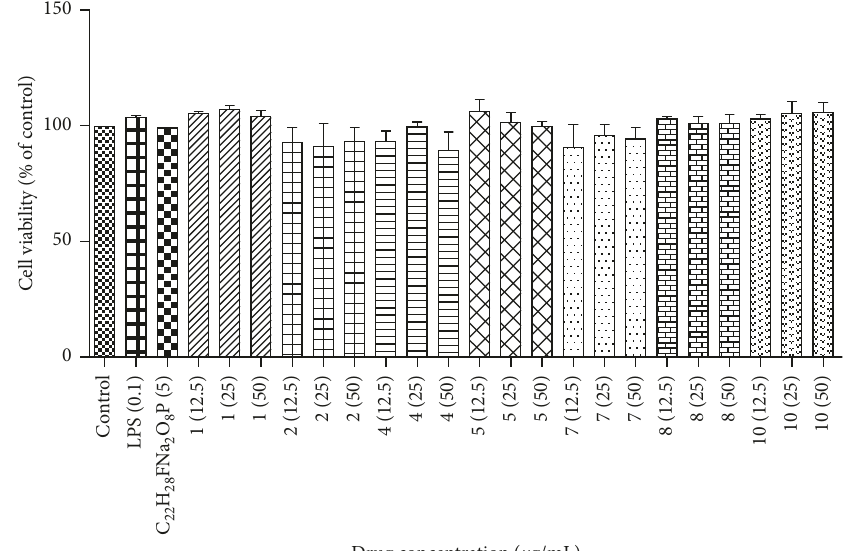
Figure 4: The effect of the isolated compounds on the survival rate of RAW 264.7 macrophage cells. The cells were pretreated with concentrations (12.5, 25, and 50 μ g/mL) of compounds ( 1 , 2 , 4 , 5 , 7 , 8 , and 10 ) or C 22 H 28 FNa 2 O 8 P (5 μ g/mL) for 1 h. The data show the mean SD of three independent experiments performed in triplicates. Arillatanoside E ( 1 ), oleanolic acid ( 2 ), trans -ferulic acid ( 4 ), trans -feruloyl- glucoside ( 5 ), 2,4,6-trimethoxy-1- O - β -D-glycoside ( 7 ), 3-methoxy-4-hydroxybenzoic acid ( 8 ), and sinapic acid ( 10 ). ±